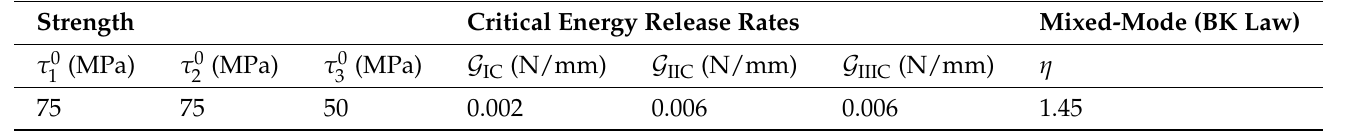
Table A3. Properties of the fibre–matrix interface used in the thermomechanical analyses